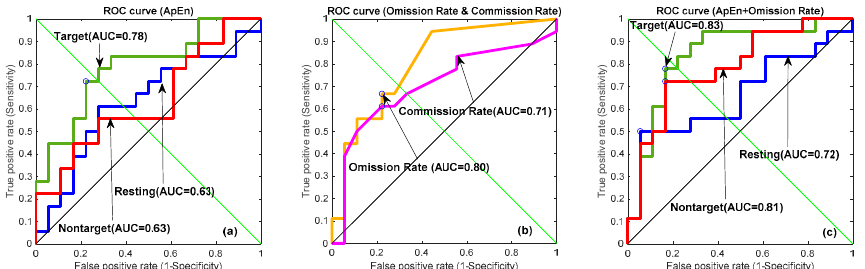
Figure 9. Receiver operating characteristic (ROC) curves depicting different variables, including ( a ) ApEn, ( b ) omission rate (%), and ( c ) a combination of ApEn and 30% omission rate between three conditions (green line: target; red line: nontarget; blue line: resting state; orange line: omission rate (%); and purple line: commission rate (%)). Table 4. Parameters of ROC curves of ApEn, omission rate (%), commission rate (%), and a combination of ApEn and omission rate.